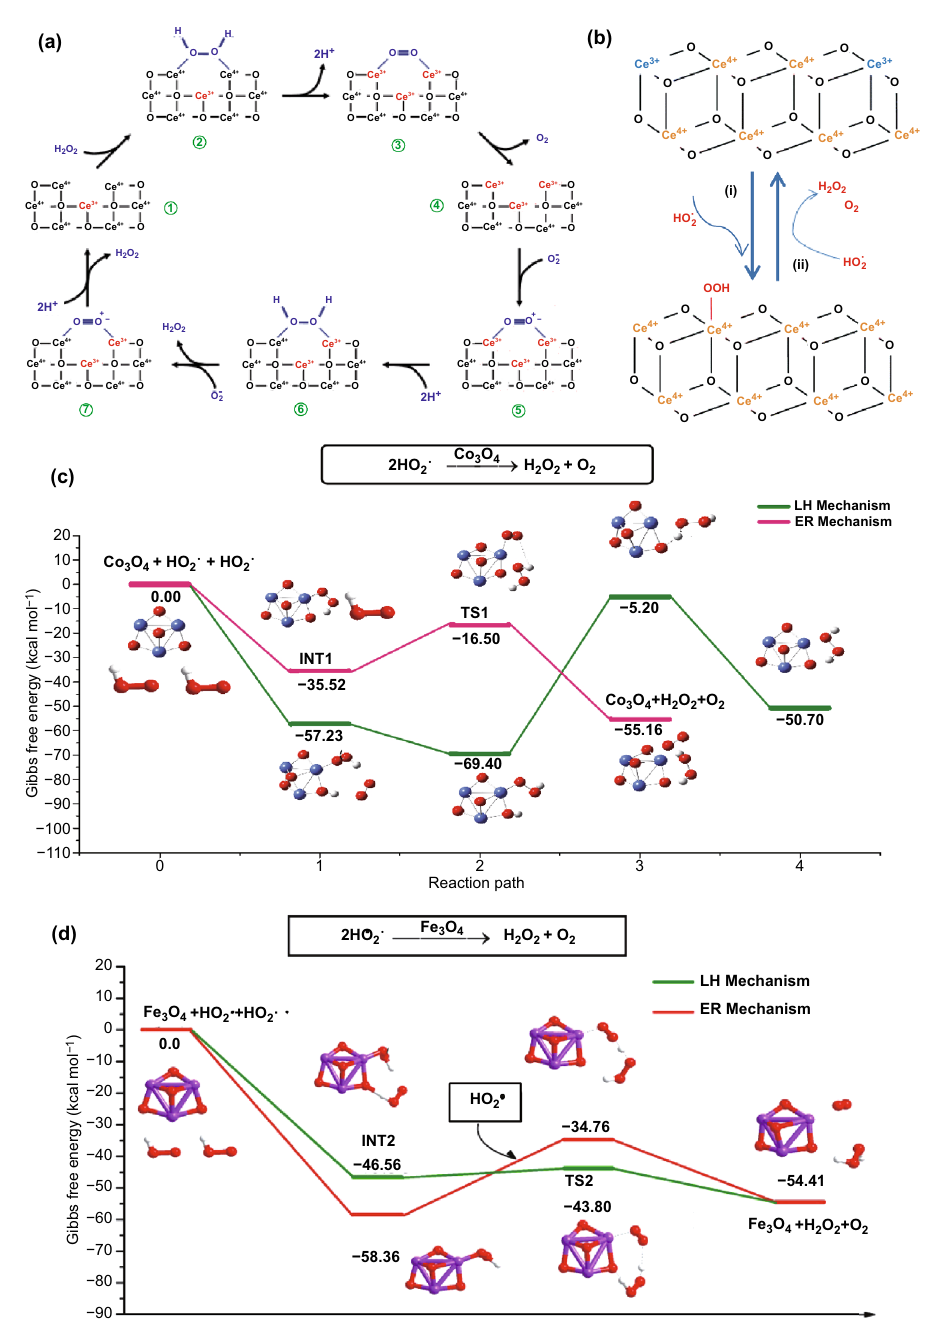
Fig. 5 a Electron transfer model for the oxidation of H 2 O 2 by nanoceria as SOD mimics. b Reaction mechanism for the SOD mimetic activity of nanoceria. c , d Calculated reaction energy profiles for the SOD-mimic activity of Co 3 O 4 and Fe 3 O 4 . Adapted from a Ref. [168], b Ref. [171], c Ref. [170], d [212] with